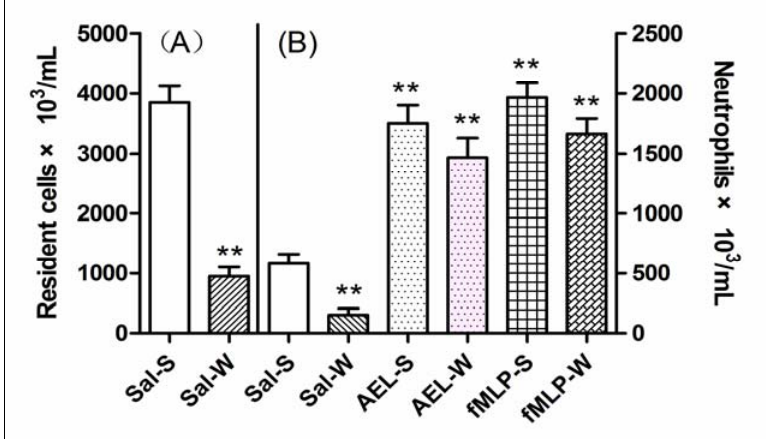
Figure 6. Reduction of resident cell population by peritoneal wash inhibits the neutrophil migration induced by AEL. ( A ) Number of mononuclear cells in sham (S) and washed (W) peritoneal cavities; ( B ) Neutrophil migration induced by saline (Sal), AEL (200 μ g/cavity in 1 mL of saline) and fMLP (10 − 7 mol) into sham (S) and washed (W) cavities. The results are reported as mean ± S.D. (n = 6). ** p < 0.01 compared with